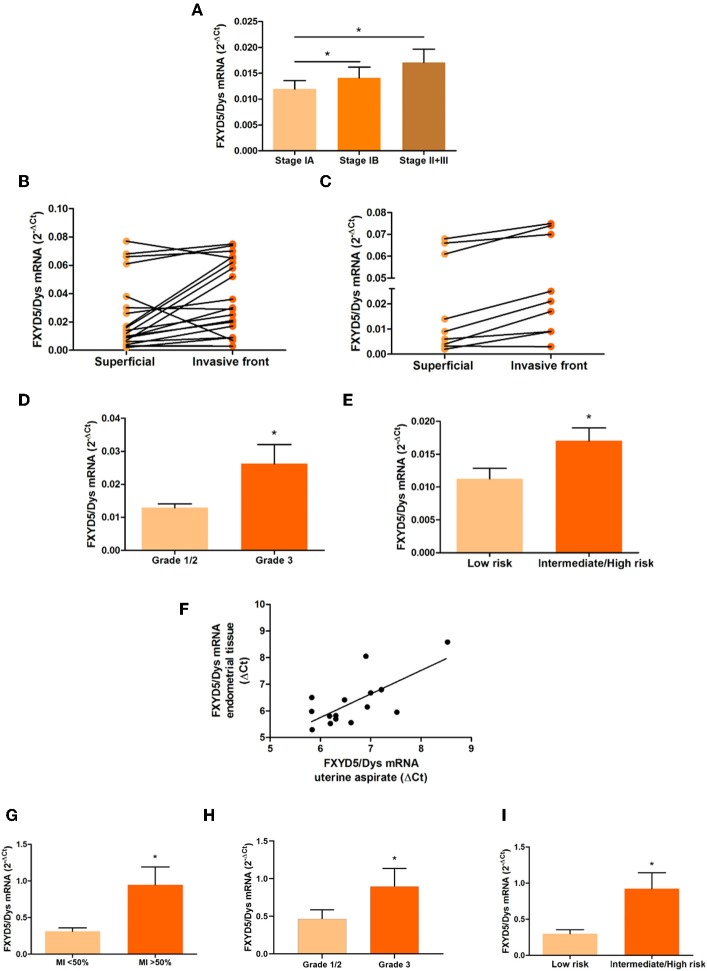
FXYD5/Dys mRNA expression and clinicopathological parameters in EC samples. (A–C) RT-qPCR analysis of FXYD5/Dys mRNA levels in (A) EEC samples grouped according to FIGO stage (Stage IA, N = 27; Stage IB, N = 15; and Stages II + III, N = 15) (differences observed between Stage IA and Stage IB tumors and between Stage IA and Stage II–III tumors; *P < 0.05, ANOVA with Bonferroni post-test), (B) paired biopsies from superficial and invasive front of EEC samples (FIGO Stages I–III) (N = 20; P = 0.0123, paired t-test), and (C) paired biopsies from superficial and invasive front of Stage I EEC samples (N = 9; P = 0.0013, paired t-test). (D) FXYD5/Dys mRNA levels in Grade 1, 2, and 3 EEC samples (Stages I–III). EEC tumors classified as Grades 1 and 2 were included in the same group (Grade 1/2). Differences observed between Grade 1/2 tumors (N = 43) and Grade 3 tumors (N = 17) (P = 0.0381; unpaired t-test with Welch's correction). (E) RT-qPCR analysis of FXYD5/Dys expression in EC samples grouped according to risk of lymph node involvement and recurrence (low risk N = 19, intermediate/high risk N = 32; P = 0.0261, unpaired t-test with Welch's correction). (F) FXYD5/Dys mRNA levels assessed in UA biopsies. Correlation analysis between mRNA levels detected in uterine aspirate biopsies and paired EC tissue (N = 15; r = 0.5321, Spearman correlation, P = 0.0412). (G–I) RT-qPCR analysis of FXYD5/Dys expression in UA from EEC grouped according to (G) MI depth (MI < 50%, N = 11; MI > 50%, N = 10; P = 0.0315, unpaired t-test, with Welch's correction), (H) tumor grade (Grades 1 and 2, N = 13; Grade 3, N = 6; P = 0.0365, Mann–Whitney test), and (I) risk of lymph node involvement and recurrence (low risk, N = 10; intermediate/high risk, N = 11; P = 0.0190, unpaired t-test with Welch's correction).